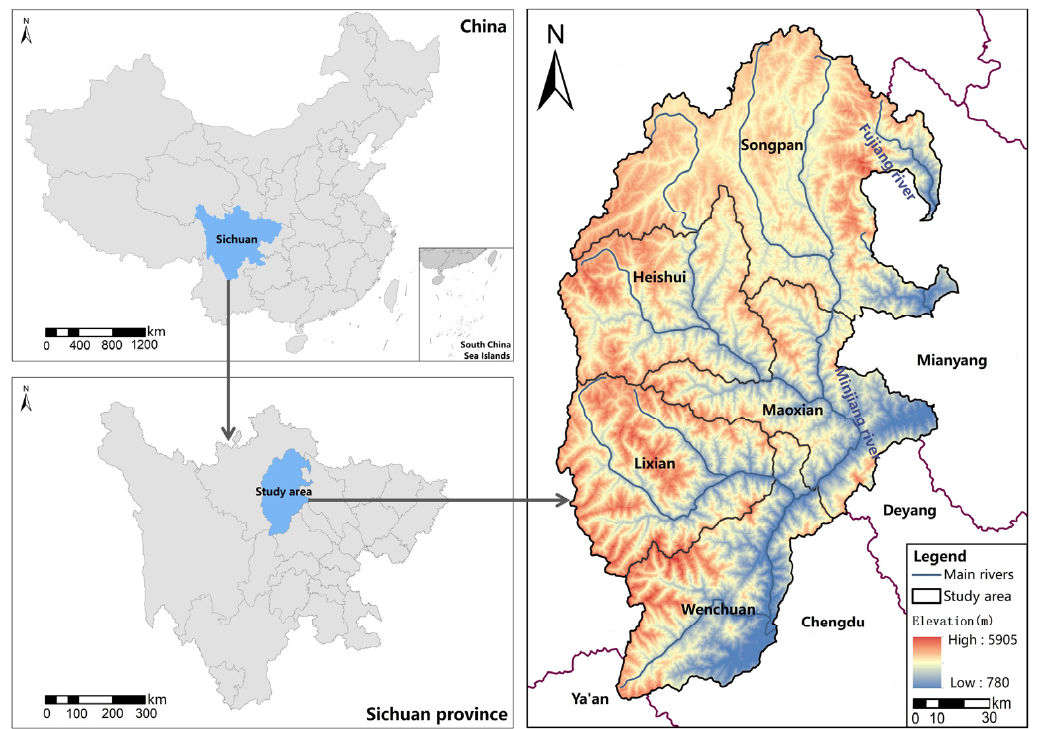
Figure 1. Location of the study area.